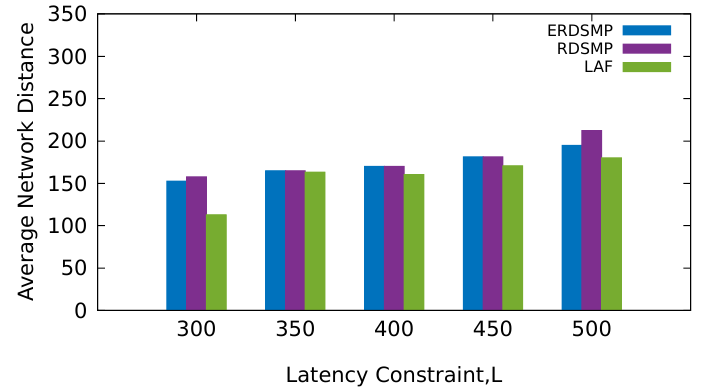
Figure 5. Average network distance for various latency,